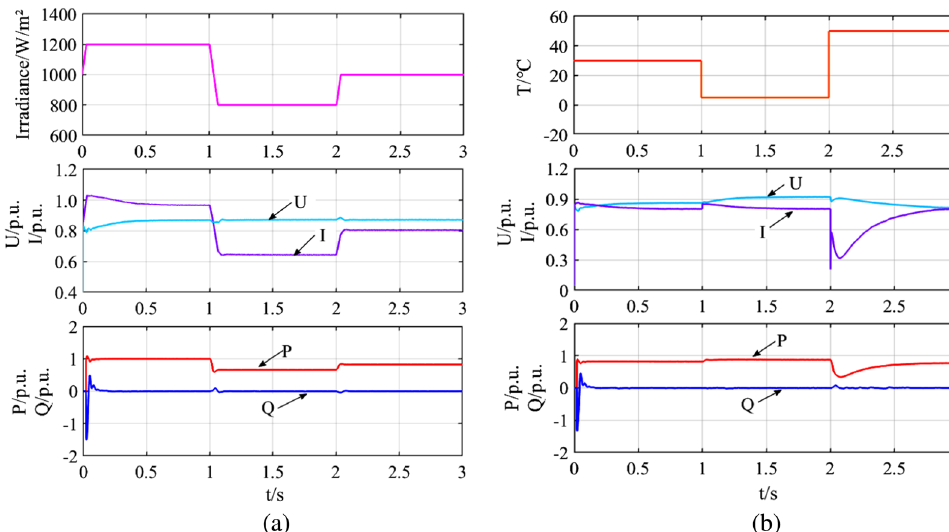
Fig. 12 Response curves of PV arrays output during external conditions changes a PV arrays output during sudden change of irradiance, b PV arrays output during sudden change of